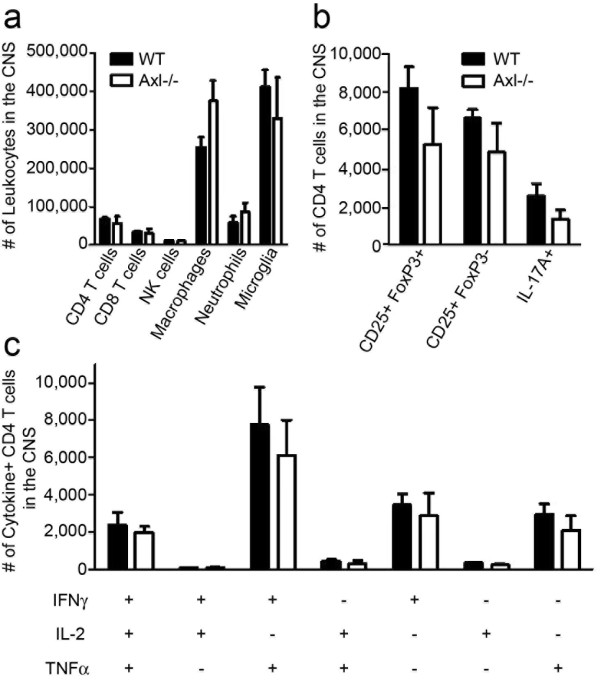
No difference in the number of leukocytes or cytokine expression from CD4+ T cells in the CNS. Mononuclear cell preparations from brain and spinal cord were stained for flow cytometric analysis to detect differences in the phenotype of cellular infiltrates (a). The gating strategy allowed us to discriminate populations of microglia, macrophages, neutrophils, NK cells, CD4 and CD8 T cells (a) as well as CD4 T cell subsets (b). CD4 T cells were restimulated with MOG35-55 peptide and analyzed for cytokine production (c). Multi-parametric flow cytometric analysis was performed on polyfunctional CD4 T cell subsets capable of producing 3, 2, or 1 cytokine(s) simultaneously. Student's t-test revealed no significant differences between WT and Axl-/- mice. These data are representative of two experiments each performed in triplicate, with 4 mice/group/experiment at day 19.